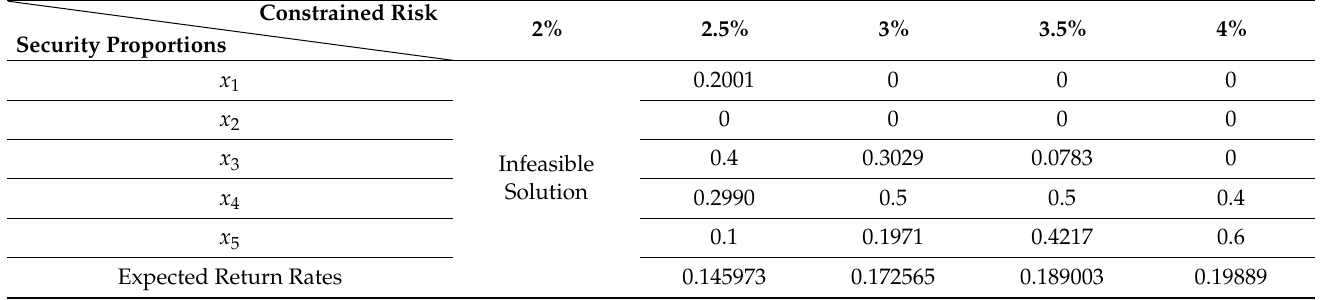
Table 12. The dimension with t = 3 and s = 3 with a guaranteed return rate (cid:101) p 3 in the proposed model.